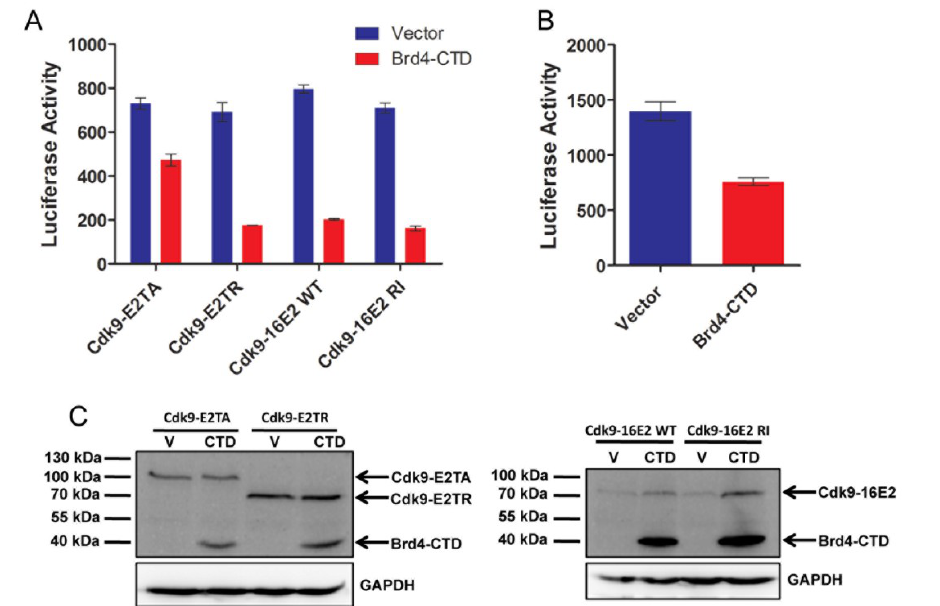
Figure 3. Brd4-CTD inhibits transcription activation by the Cdk9-E2 fusion proteins. ( A ) Along with the p2x2xE2BS-Luciferase construct, C33A cells were cotransfected